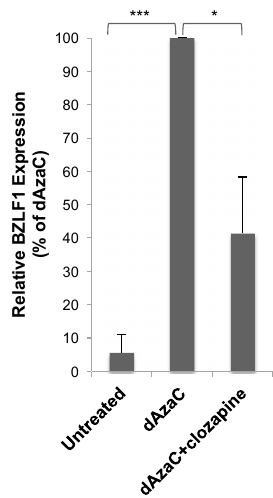
Figure 5. Clozapine decreased EBV lytic BZLF1 expression induced by 5-aza-2’-deoxycytidine (dAzaC). BZLF1 expression was measured in HH514-16 cells after treatment for 24 h with dAzaC (10 µ M) alone or combined with clozapine (50 µ M) and compared to untreated cells. The average of six biological replicates was plotted as a percentage of BZLF1 expression induced by dAzaC. p -value < 0.05 is denoted with *, p -value < 0.001 with